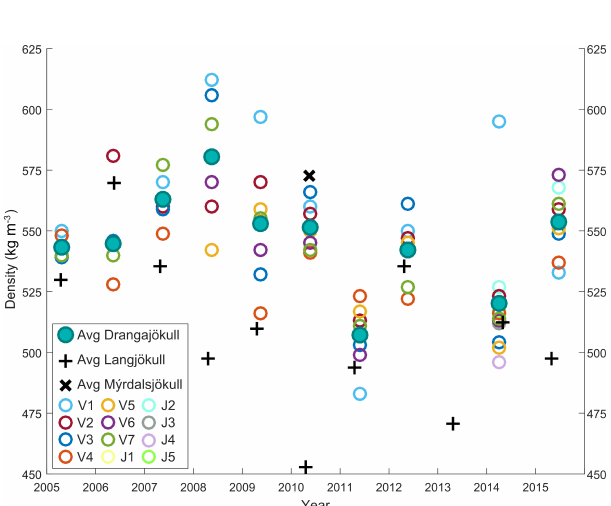
Figure 7. The density values obtained at each in situ location for field campaigns 2005–2015. Each circle represents the average den- sity of the shallow core at each in situ location. Blue filled circles show the average density measurements. Black “ + ” shows the av- eraged density measured on Langjökull, and black “ × ” shows the averaged density measured on Mýrdalsjökull ice cap in year 2010 (Ágústsson et al., 2013). The 2013 campaign was not carried out due to bad weather